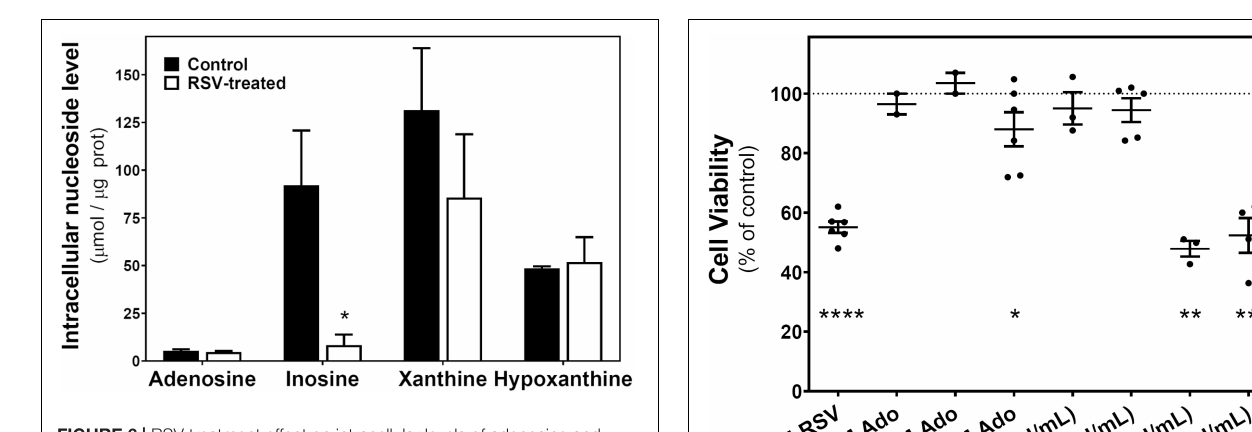
FIGURE 6 | RSV treatment effect on intracellular levels of adenosine and related metabolites in C6 glioma cells. Cells were exposed to RSV at 100 µ M for 24 h and adenosine, inosine, xanthine, and hypoxanthine were quantified by HPLC as described in “Materials and Methods.” Data are means ± SEM of three to four independent assays. * p < 0.05 significantly different from the control condition according to Student’s t -test.